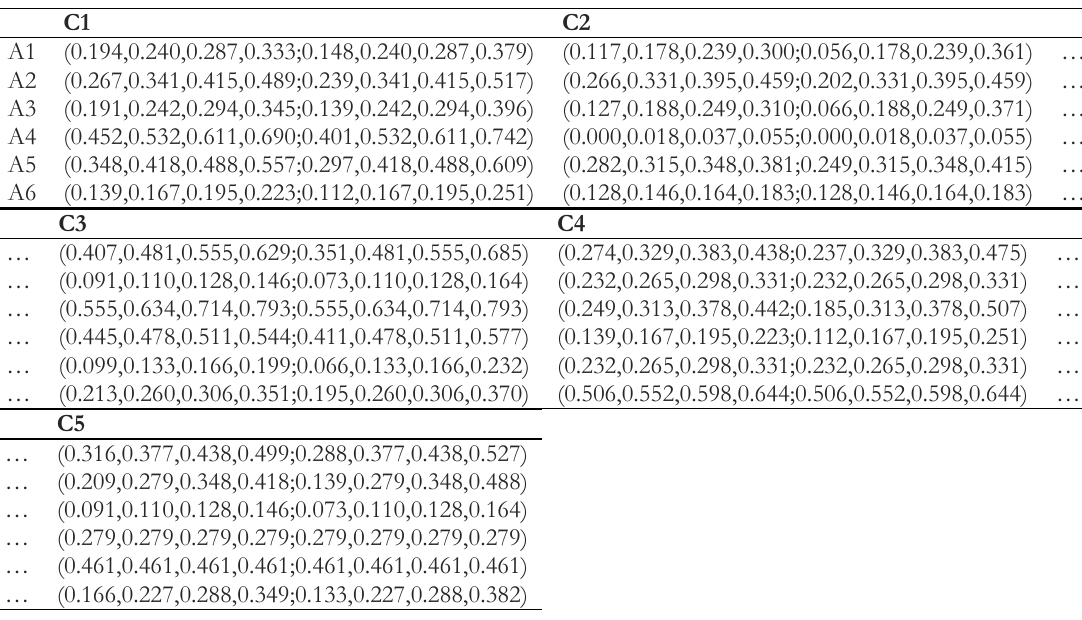
Table 7. Aggregated IFN of preferences for all